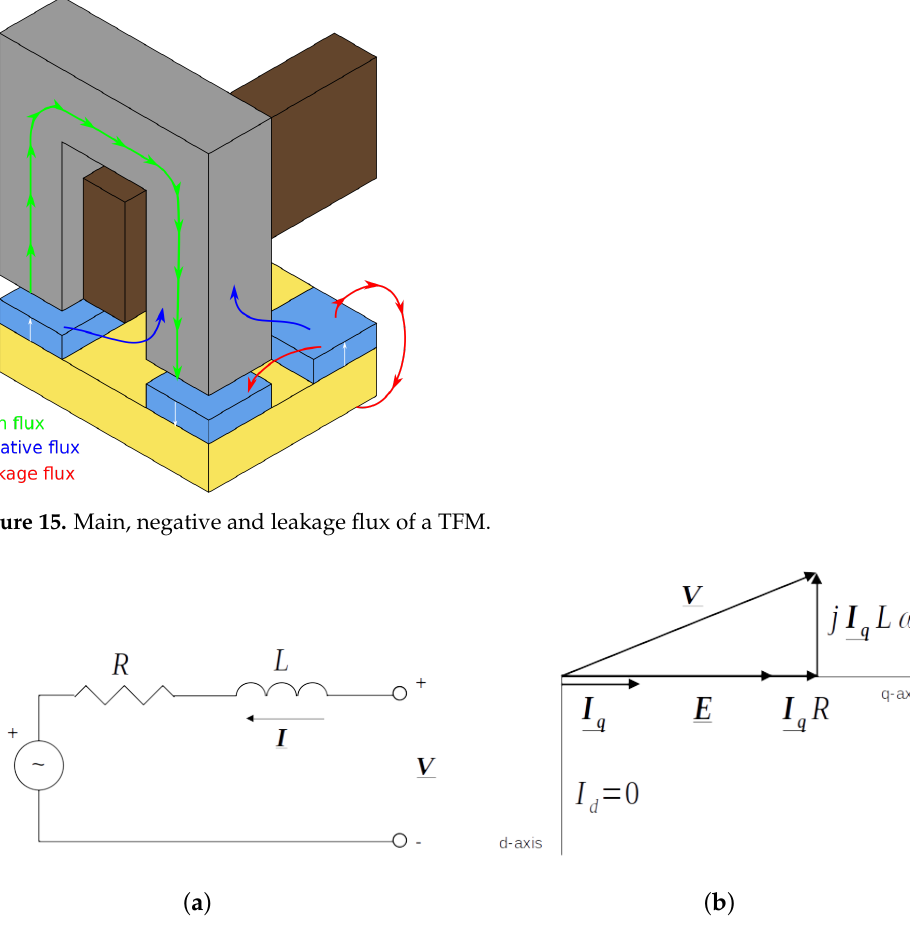
Figure 16. ( a ) Equivalent circuit, and ( b ) phasor diagram of the simplified iq control of a synchronous